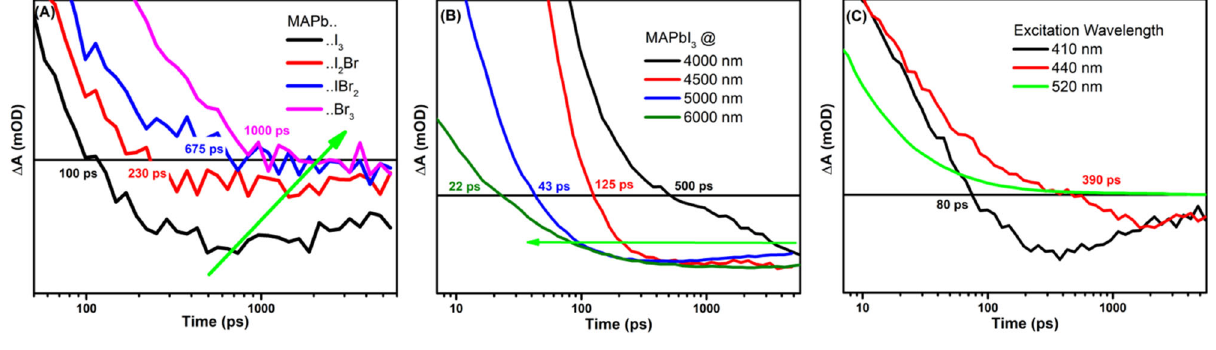
Fig. 4 Dependence of various factors on the observed transient mid-IR signal. Dependence on chemical composition: ( A ) Normalized kinetic traces at 4900nm extracted form MAPbI n Br 3-n fi lms using 520 nm as excitation showing the appearance of negative signals. Dependence on mid-IR detection window: ( B ) Normalized Kinetic traces for MAPbI 3 fi lm under excitation of 520nm and at different probing wavelengths showing the appearance of negative signals. Dependence on excitation wavelengths: ( C ) Normalized kinetic traces for MAPbI 3 fi lm under various excitation wavelengths showing the appearance of negative